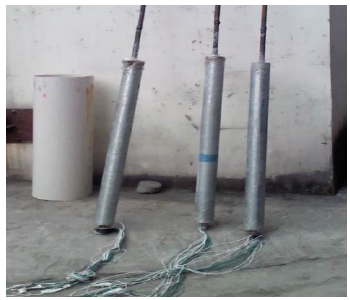
Figure 4. Section of rock bolts (unit: mm).